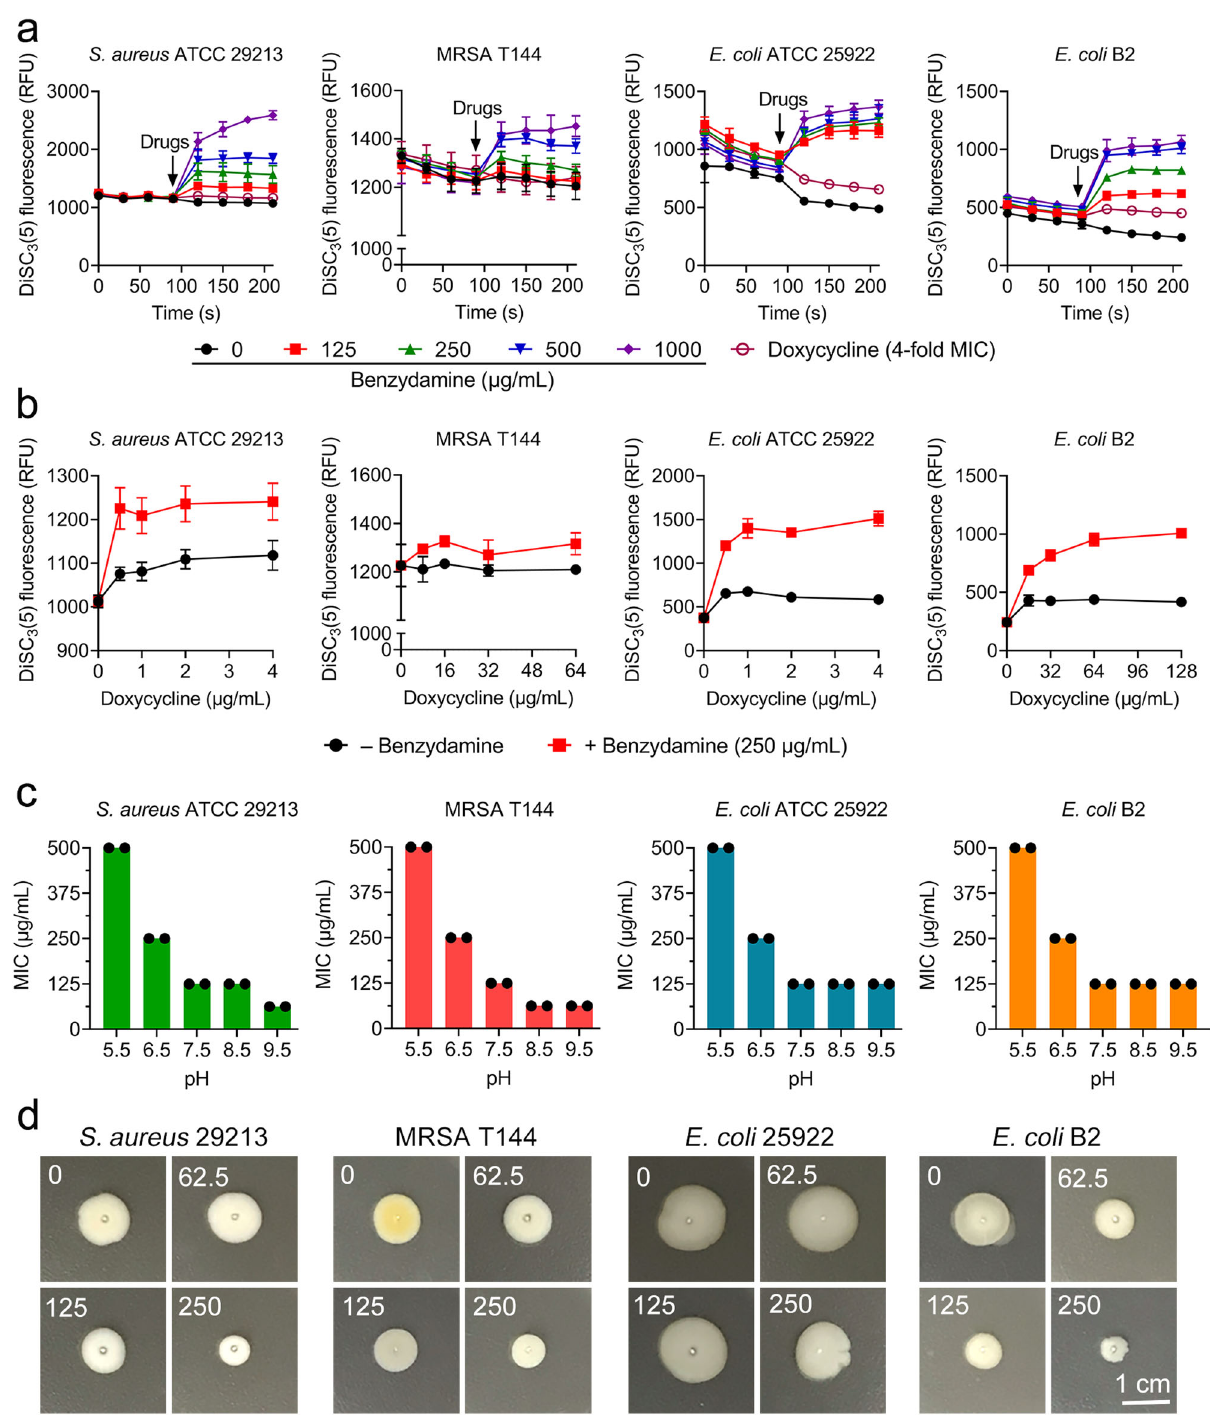
Fig. 2 Benzydamine disrupts proton motive force (PMF) in both Gram-positive and Gram-negative bacteria. a Benzydamine dissipates membrane potential in bacteria. Fluorescence intensity of DiSC 3 (5) in S. aureus ATCC 29213, MRSA T144, E. coli ATCC 25922, and E. coli B2 after treatment with increasing concentrations of benzylamine and doxycycline (fourfold MIC) was monitored. Drugs were added into DiSC 3 (5)-probed cells at 90 s. b Combination of doxycycline and benzydamine (250 μ g/mL) displays increased disruption on membrane potential compared with doxycycline alone. c Decreased MIC values of benzydamine against four strains in an alkaline environment. ▵ Ψ becomes the main component of PMF as the external pH is shifted to an alkaline environment. d Benzydamine inhibits the swimming motility of four bacterial strains. Overnight cultures were standardized to OD 600 nm of 0.5, and inoculated on 0.3% agar plates for 48 h at 37 °C. Scar bar, 1